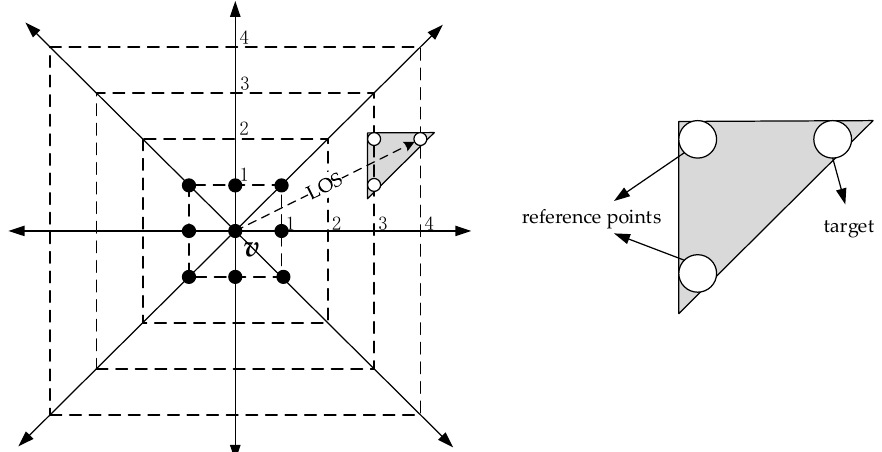
Figure 2. The procedure of XDraw. First, XDraw assumes that the eight neighboring points near the viewpoint are visible. Second, XDraw applies the direct LOS method on the eight directions (vertical, horizontal and diagonal directions). Finally, for targets in eight octants, XDraw determines the visibility in layers from the viewpoint to the boundary of the analysis area. Each target relies on two reference points on the previous layer to calculate the visibility.